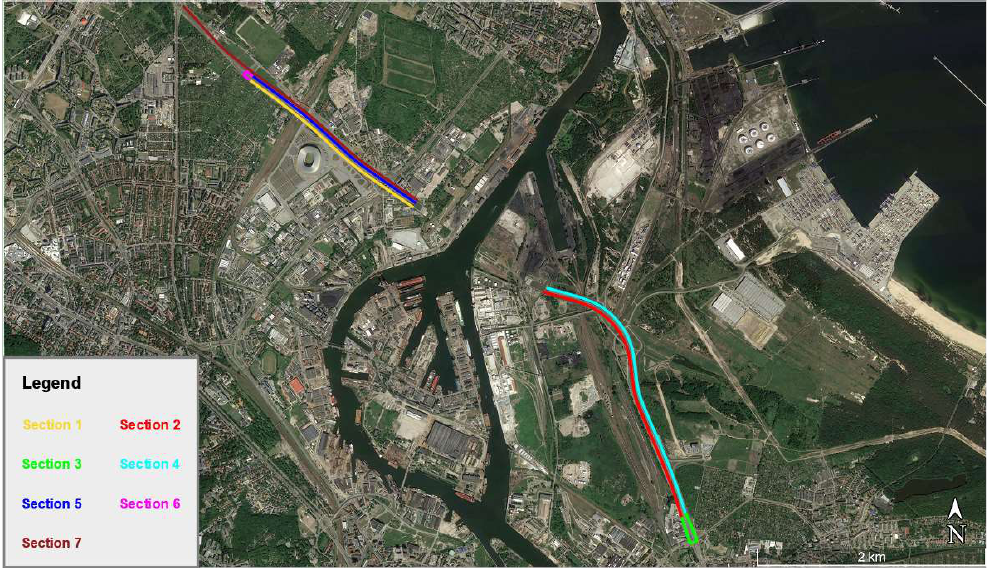
Figure 6. Division of the route into test sections.